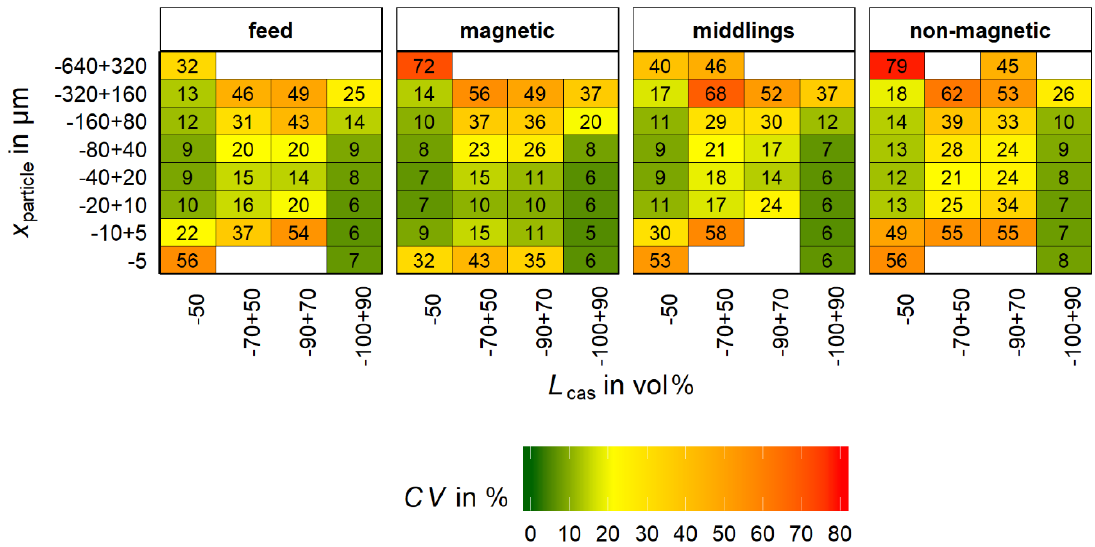
Figure 9. Distribution of cassiterite ( r cas ) as a function of x particle classes and L cas classes (recovery in each product sums up to 100%; green: 1%, yellow: 17.5%, red: 35%). The numbers in the boxes indicate the amount of particles in each bin.